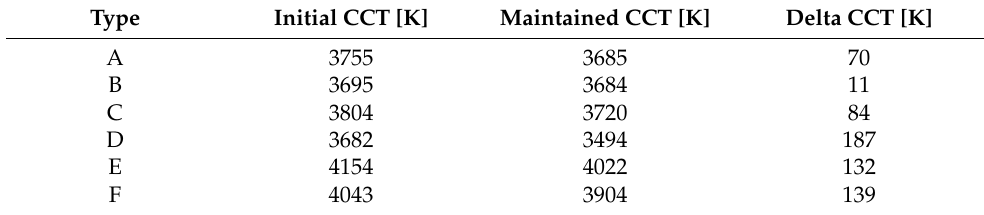
Table 5. CCT maintenance characteristics of OLED products with operating of six thousand hours.